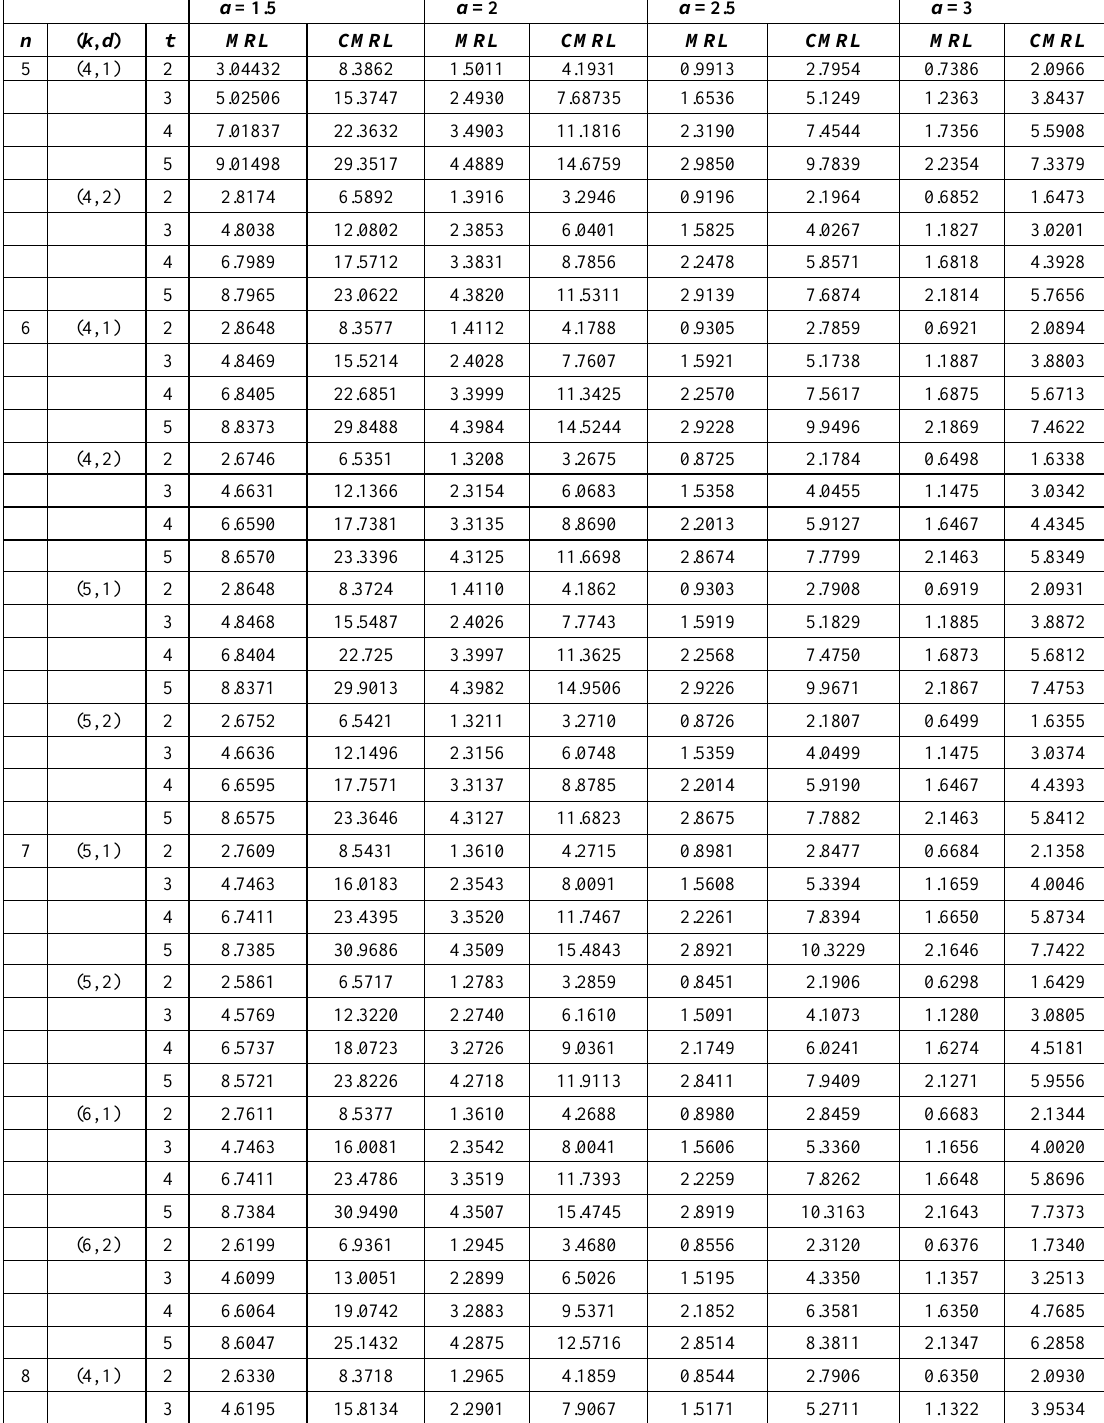
Table 3. The MRL and CMRL of the C ( k,d,n ) model under the multivariate Pareto